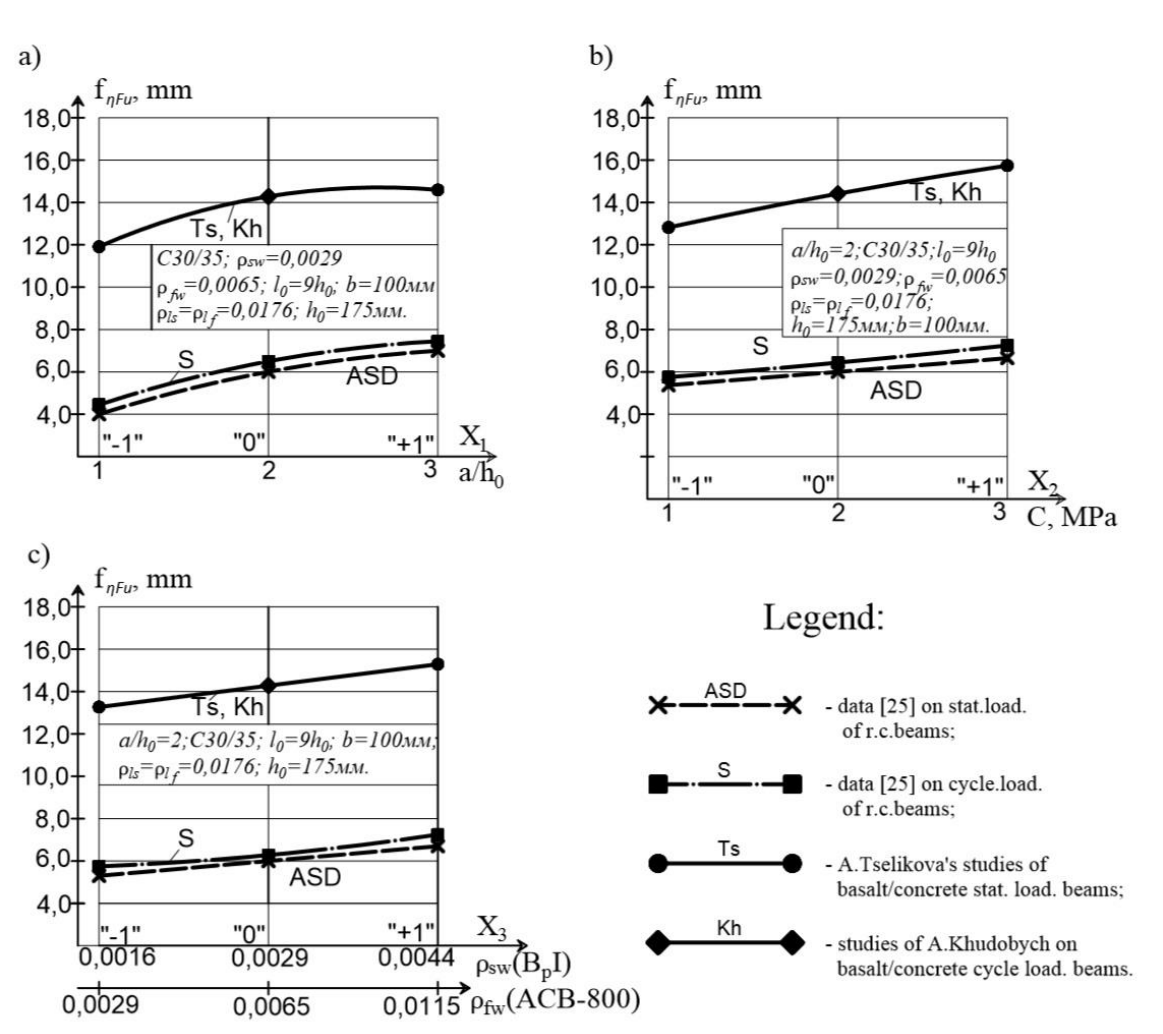
Figure 3. Impact of the design factors (relative shear span (а), concrete grade (b) and quantity of the transverse reinforcement (c) on the test beam sample deflections before their collapse